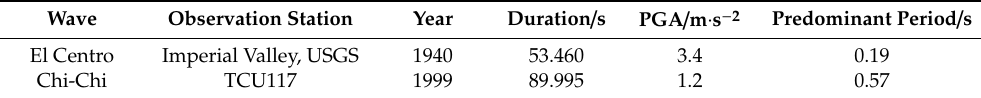
Table 4. Original shaking wave Table 4. Original shaking wave details. Table 4. Original shaking wave details. Table 4. Original shaking wave details. Table 4. Original shaking wave details. Table 4. Original shaking wave details. Table 4. Original shaking wave details. Table 4. Original shaking wave details.